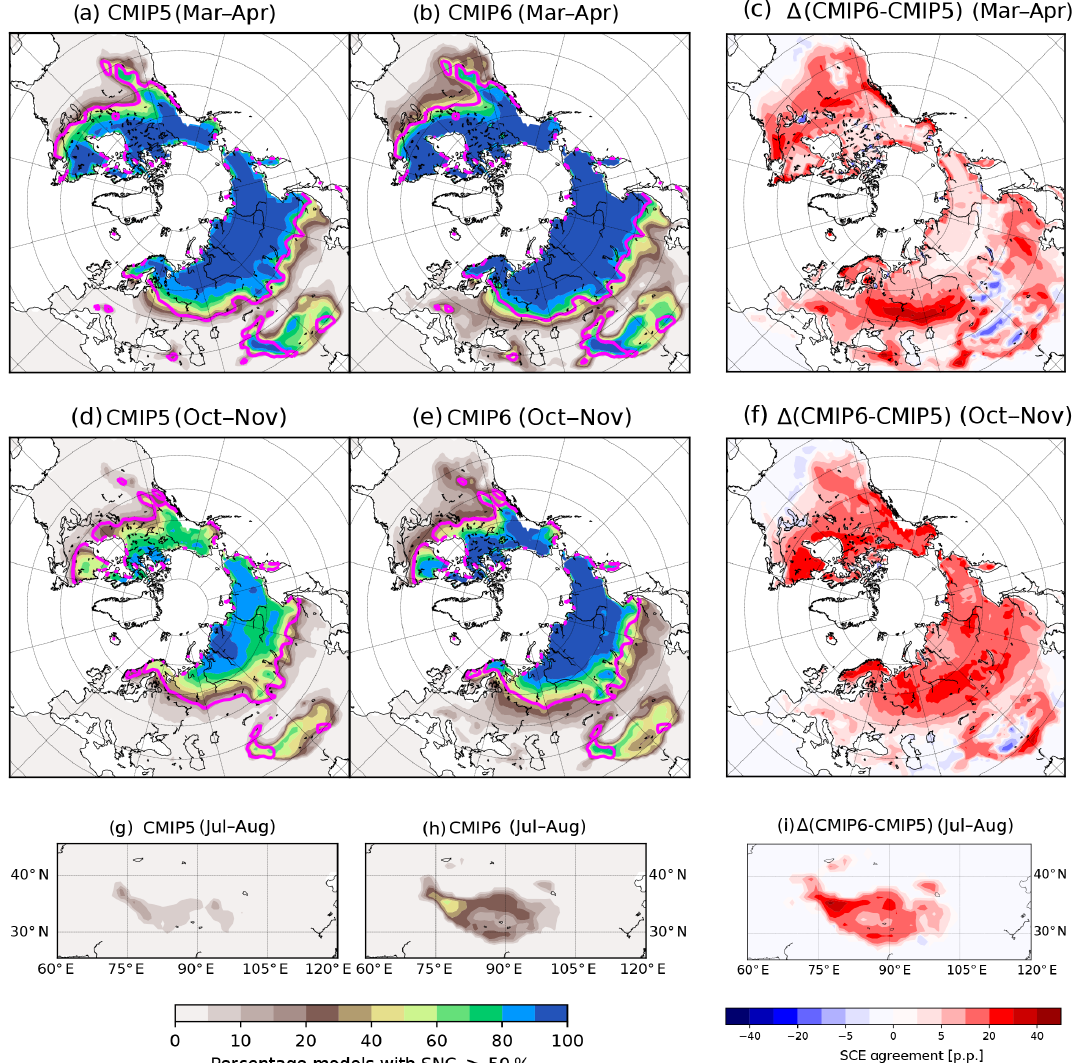
Figure 5. Percentage of models simulating more than 50% snow cover in the Northern Hemisphere during March–April (a–c) and October– November (d–e) for 1981–2014, for CMIP5 (a, d) and CMIP6 (b, e) . The 50% snow cover frequency line from the NOAA data for the same months during that period is shown in pink. Percentage of models simulating more than 50% snow cover in high-mountain Asia during July–August for 1981–2014, for CMIP5 (g) and CMIP6 (h) . Differences (CMIP6 minus CMIP5) are shown in panels ( c , f , and i ).